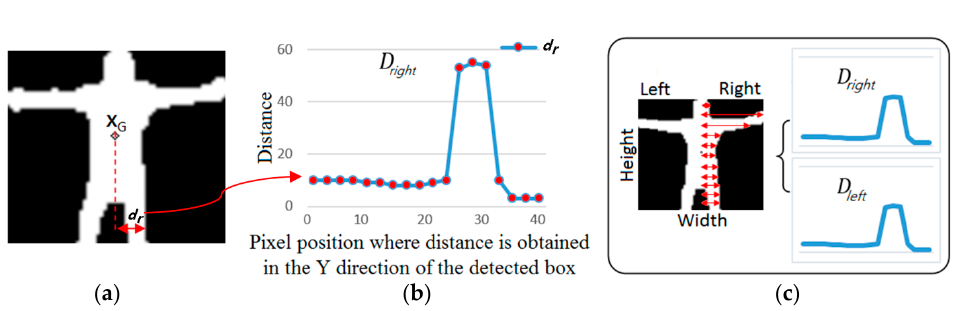
Figure 6. Example of profile graphs produced by the proposed PbD method. ( a ) Binarized image of human area in the detected box; ( b ) profile graph representing the right part of the human area; ( c ) two profile graphs representing the right and left parts of the human area, respectively.